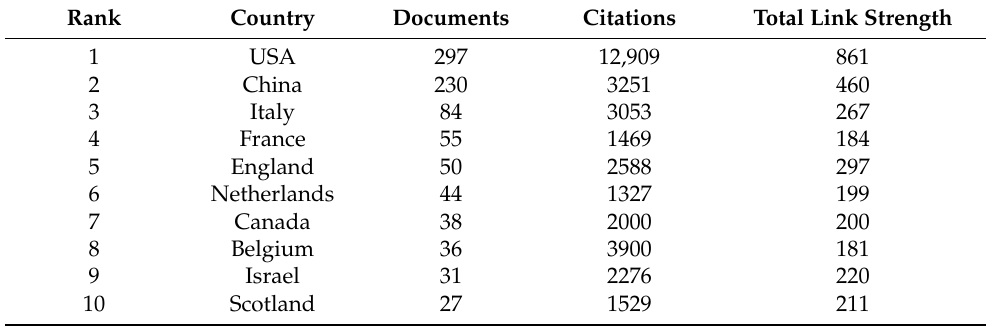
Table 1. Top 10 most productive countries with publications on therapy for POI from 2000 to 2022.